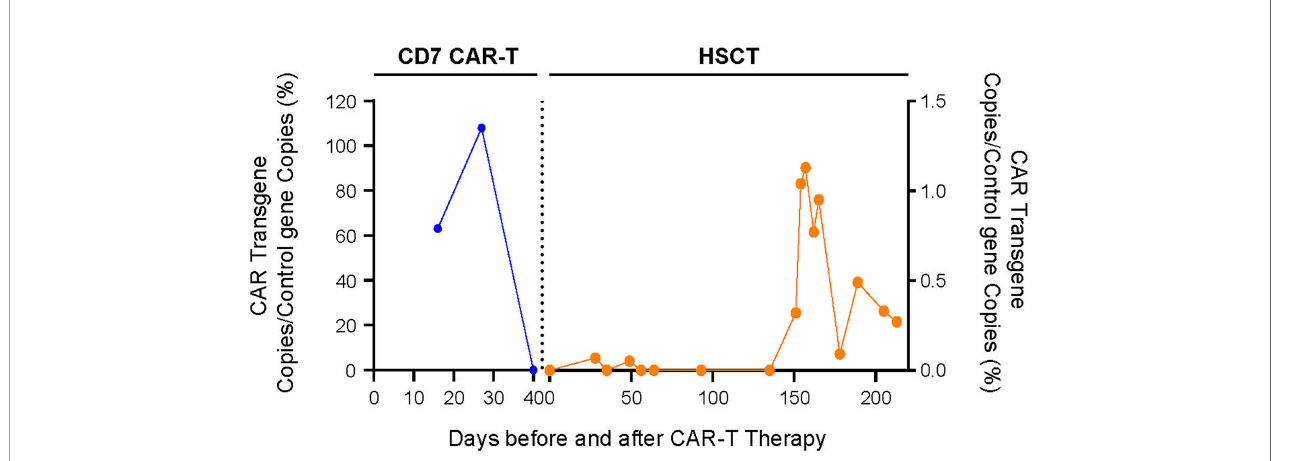
FIGURE 2 | PCR was used to monitor the change trend of CD7 CAR T-cell count in vivo during CAR-T and